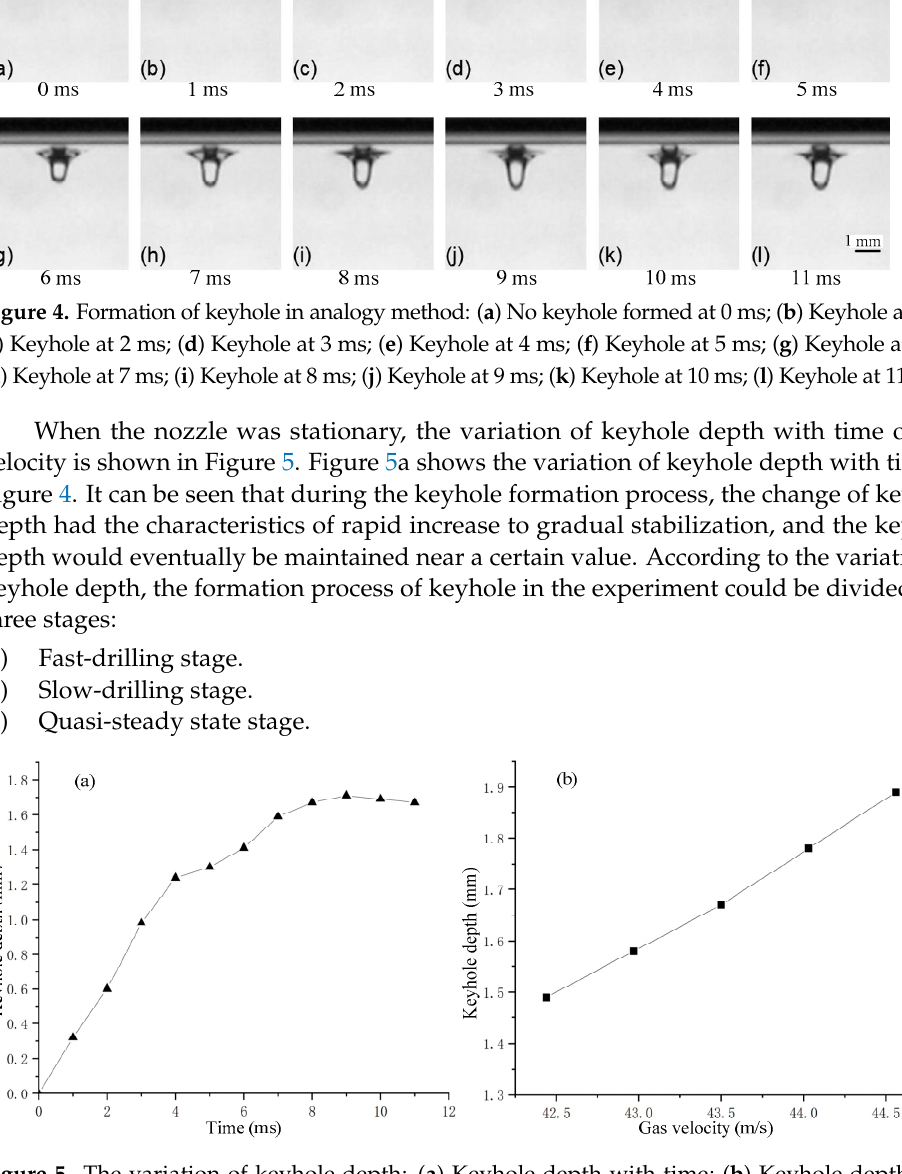
Figure 5. The variation of keyhole depth: ( a ) Keyhole depth with time; ( b ) Keyhole depth with gas velocity.